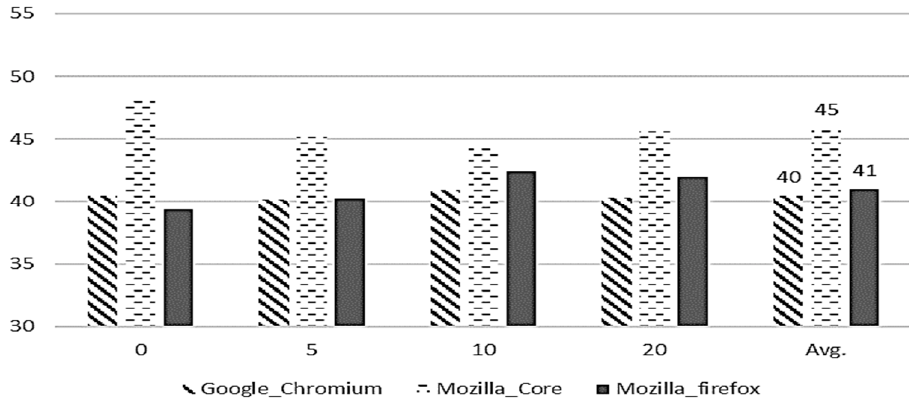
Figure 8. Precision result between for each project.